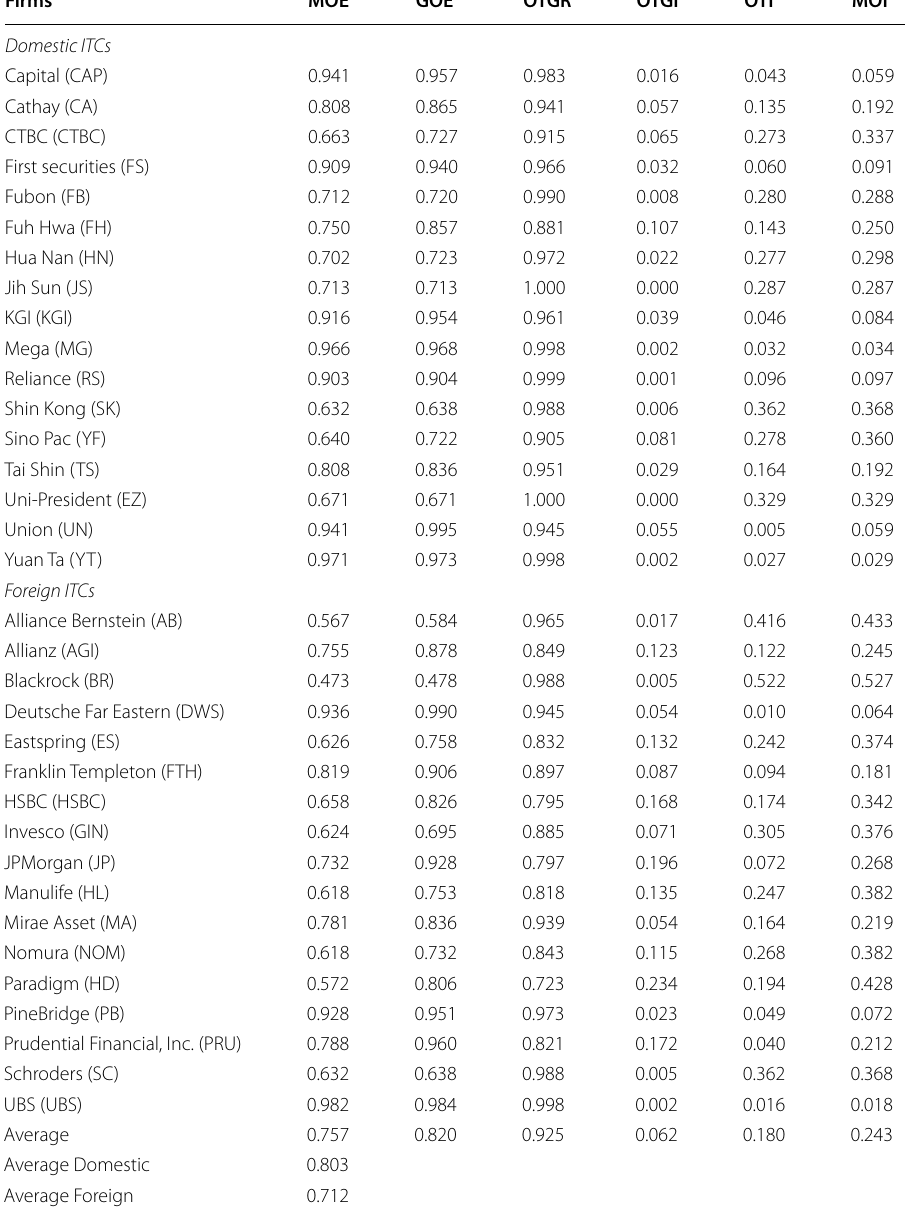
Table 6 Average operational efficiencies and metafrontier inefficiencies from 2011 to